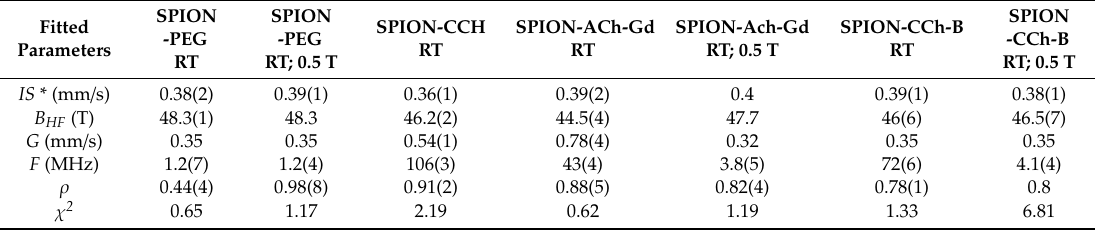
Table 2. Hyperfine parameters obtained from the fits of the Mössbauer spectra of nanoparticle materials studied at room